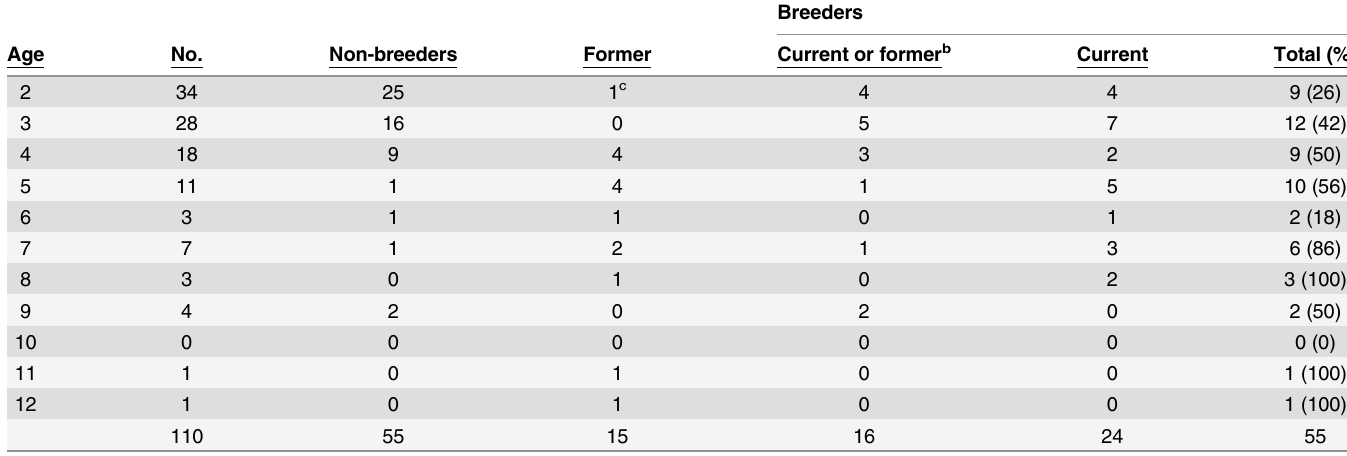
Table 1. Female wolf breeder types in the Superior National Forest, 1972 – 2013 based on Mech et al. [24] formula a